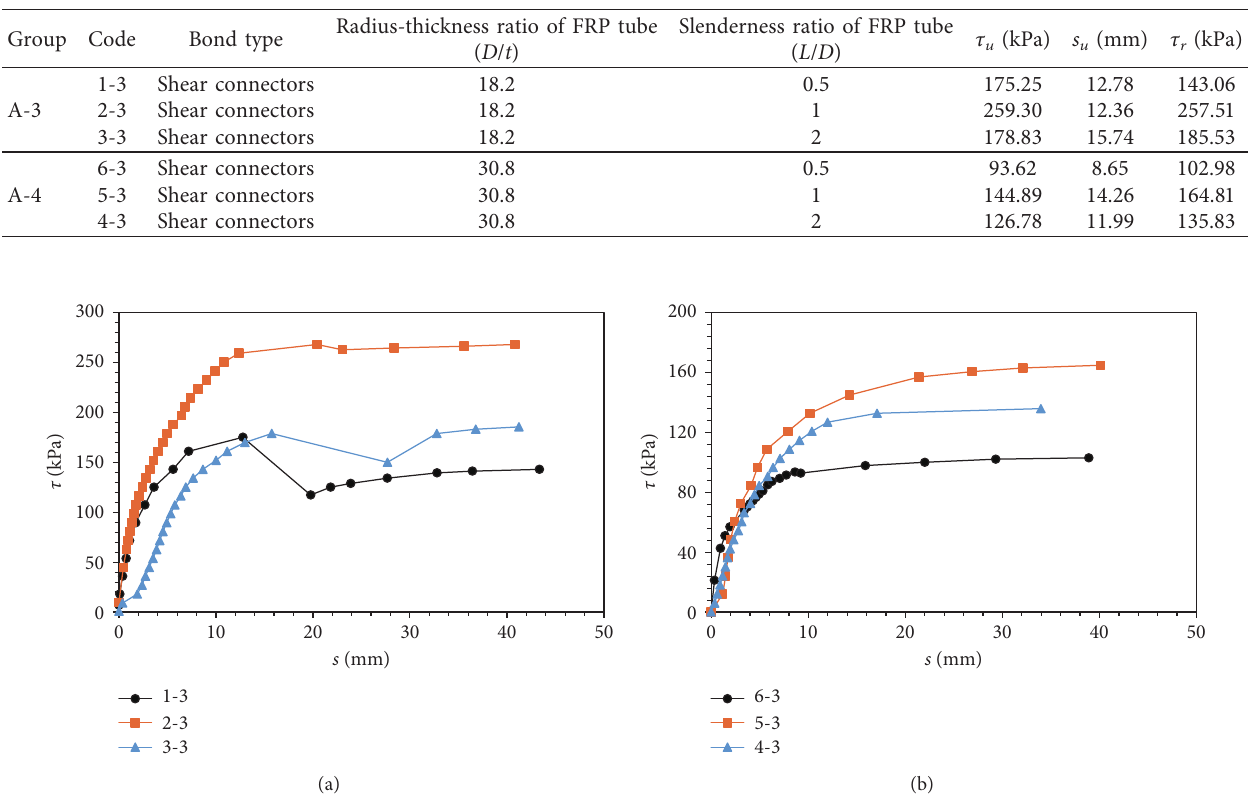
Table 6: Test results of specimens of Groups A-3 and A-4.